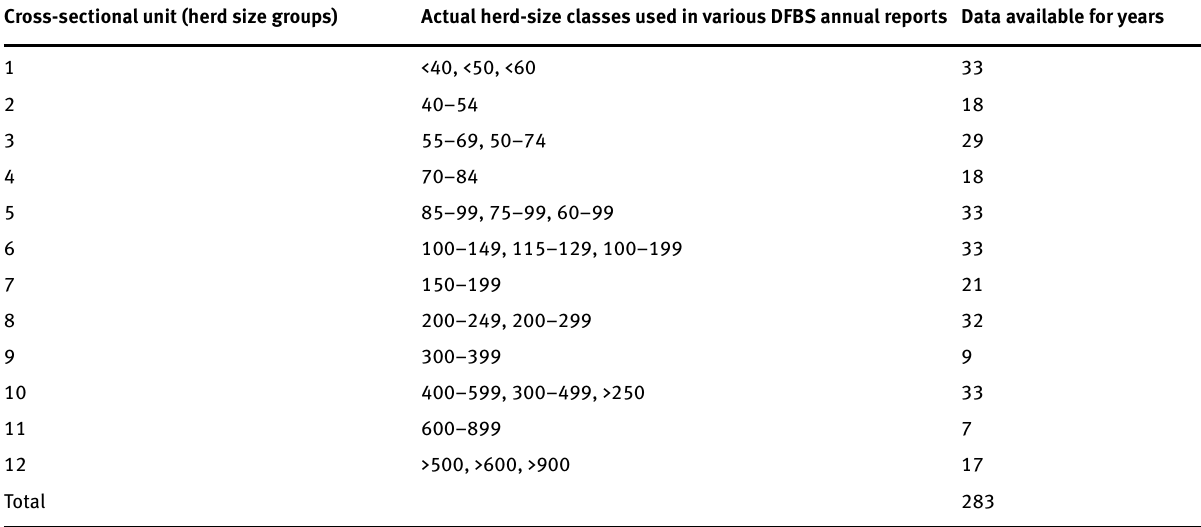
Table 1: Changing definition of size-groups in DFBS data and redefined size groups in the dataset used for analysis Cross-sectional unit (herd size